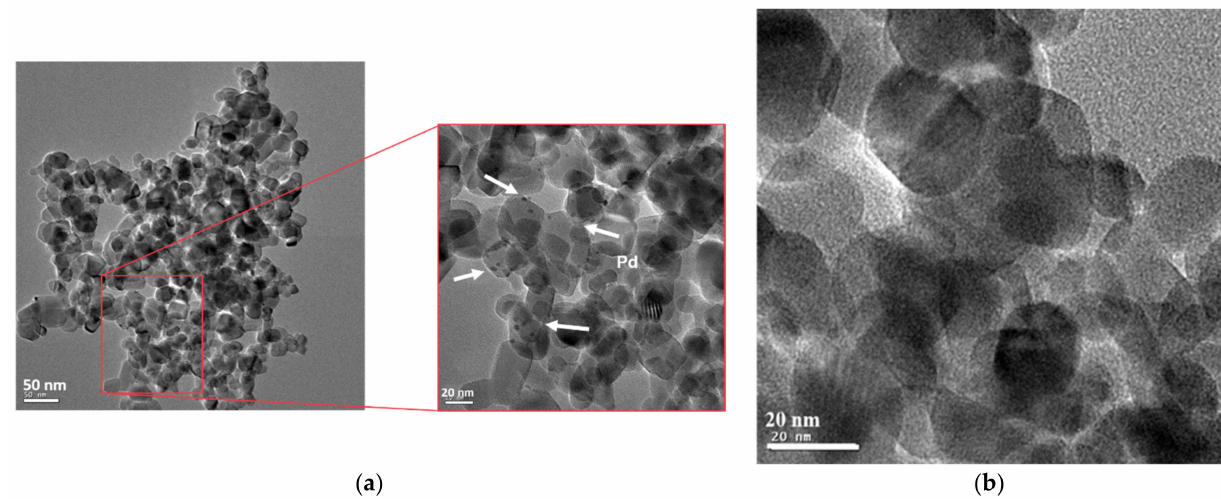
Figure 3. HRTEM images of ( a ) Pd/TiO 2 and ( b ) Cu/TiO 2 . The EDS mapping of each element on Pd/TiO 2 are shown in Figure 4. It clearly shows that Pd metal particles were homogeneously distributed on the surface of TiO 2 , in consis- tent with HR-TEM result. Figure 5 shows the EDS mapping of each element on Cu/TiO 2 . Cu metal particles were also homogeneously distributed on the surface of TiO 2 . The EDS results also show that the Pd and Cu metal loadings are 0.498 wt.% and 0.506 wt.%, respec- tively. The real metal loadings are the same as the nominal loadings within experimental error. Since the catalysts were prepared by incipient-wetness impregnation, it is very easy to have the same metal loading as that in the precursor.